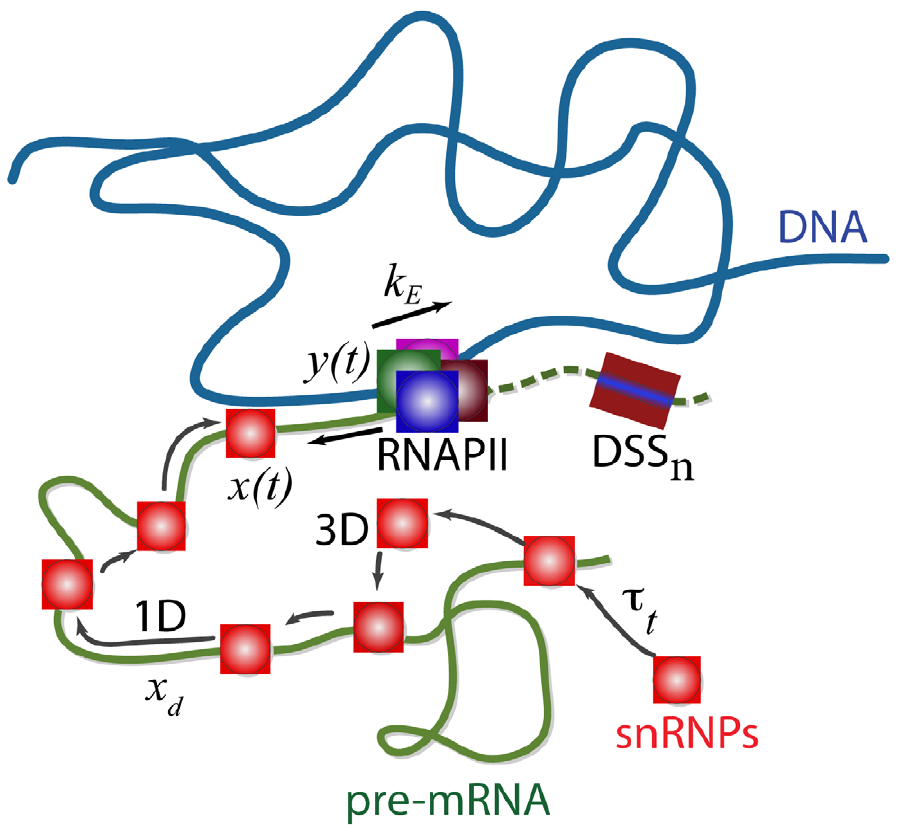
Figure 1. Schematic description of the various simultaneous processes that take place when splicing is coupled to transcription. In this scheme, the RNAPII complex has already initiated transcription and is currently in the transcriptional elongation step with an elongation rate k E (bases s 2 1 ). The RNAPII complex is located at position y(t) on the pre-mRNA chain. The snRNPs can locate the 5 9 donor splicing site (DSS n ) at position n either via a pure three-dimensional diffusion process or via a combination of three- and one-dimensional diffusion. Here the snRNP has already non- specifically bound the pre-mRNA and is shown scanning the pre-mRNA at position x(t) . DSS n has not been transcribed yet in this scheme.